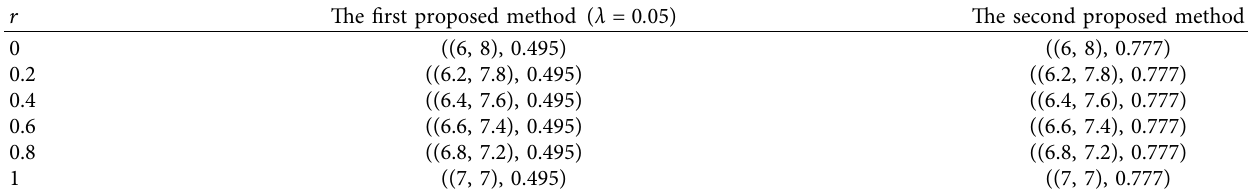
Table 6: Comparison of 􏽥 u ( r ) result using the two proposed methods ( λ � 0 . 05 ) . 1